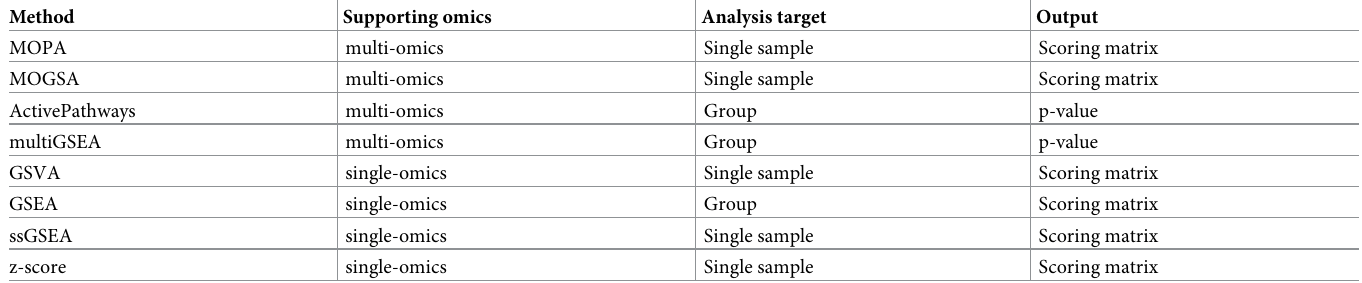
Table 1. Comparison of multi-omics pathway analysis